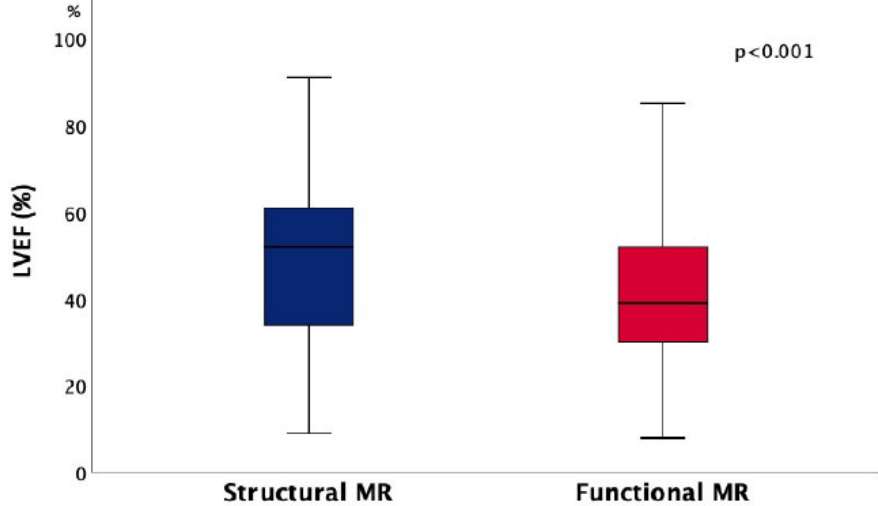
Figure 3. Differences in left ventricular ejection fraction (LVEF) between patients with structural and functional mitral regurgitation (MR).